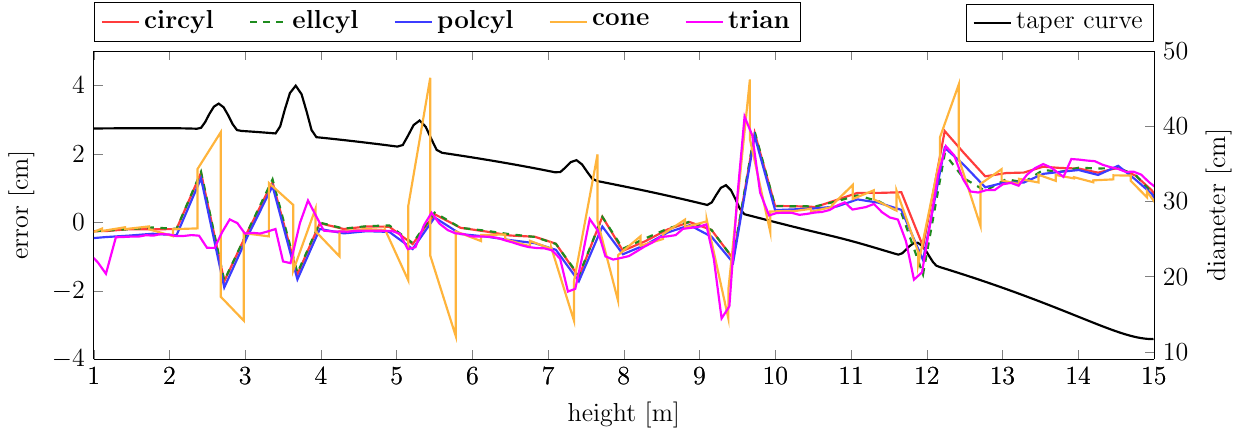
Figure 7. Taper error curves. Taper curve for the generated Stem 7 (right axis) and the diameter error (left axis) in the taper curves of the reconstructed